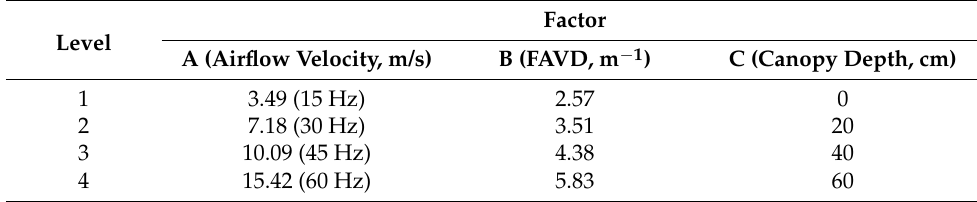
Table 8. Orthogonal test factors and levels.